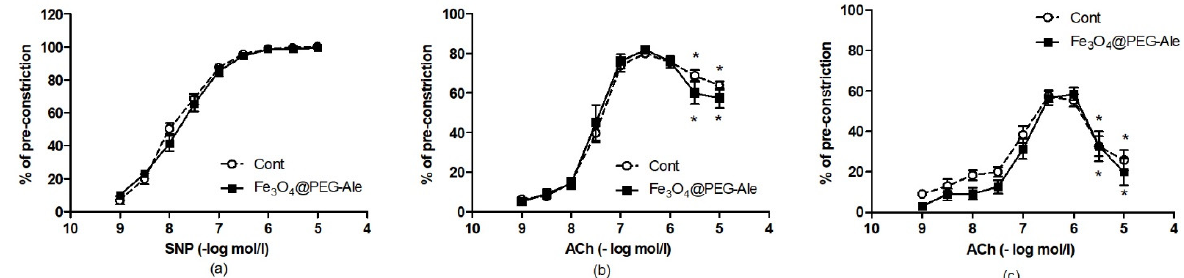
Figure 10. ( a ) Sodium nitroprusside-induced relaxation and acetylcholine-induced relaxations ( b ) in the absence and ( c ) presence of L-NAME in the femoral arteries. The values represent the mean ± SEM, n = 12 per group. * p < 0.05 vs. the maximal relaxation in the same group. Cont, control; Fe 3 O 4 @PEG-Ale, Fe 3 O 4 @PEG-alendronate nanoparticles, ACh, acetylcholine; SNP, sodium nitroprusside.